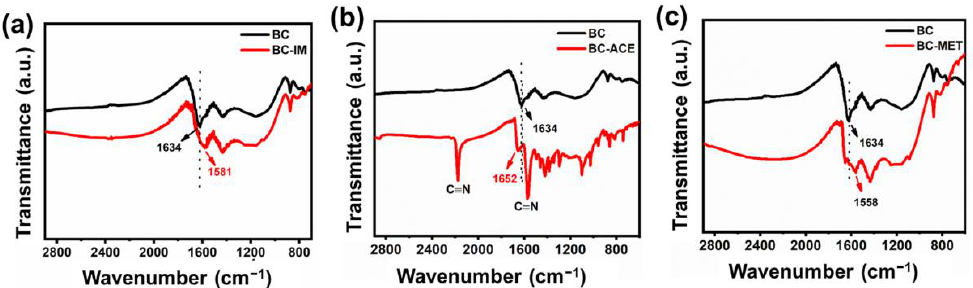
Figure 7. FTIR spectra of BC (black) and the spent BC samples (red) after treated with ( a ) imidacloprid (IM), ( b ) acetamiprid (ACE) and ( c ) methomyl (MET). That may result from the interaction between aromatic derivatives present in the BC and pesticide molecules through the π-π interaction [75–77] formed between the pyridine rings (in imidacloprid and acetamiprid) and N-H (in methomyl), as proposed in Scheme 1. Another possible interaction is the OH (in alcohol, phenol, and carboxyl groups) and C=O (in carboxyl groups) on the BC surface interacting with the pesticide molecules by an H-bonding interaction, as illustrated in Scheme 2.